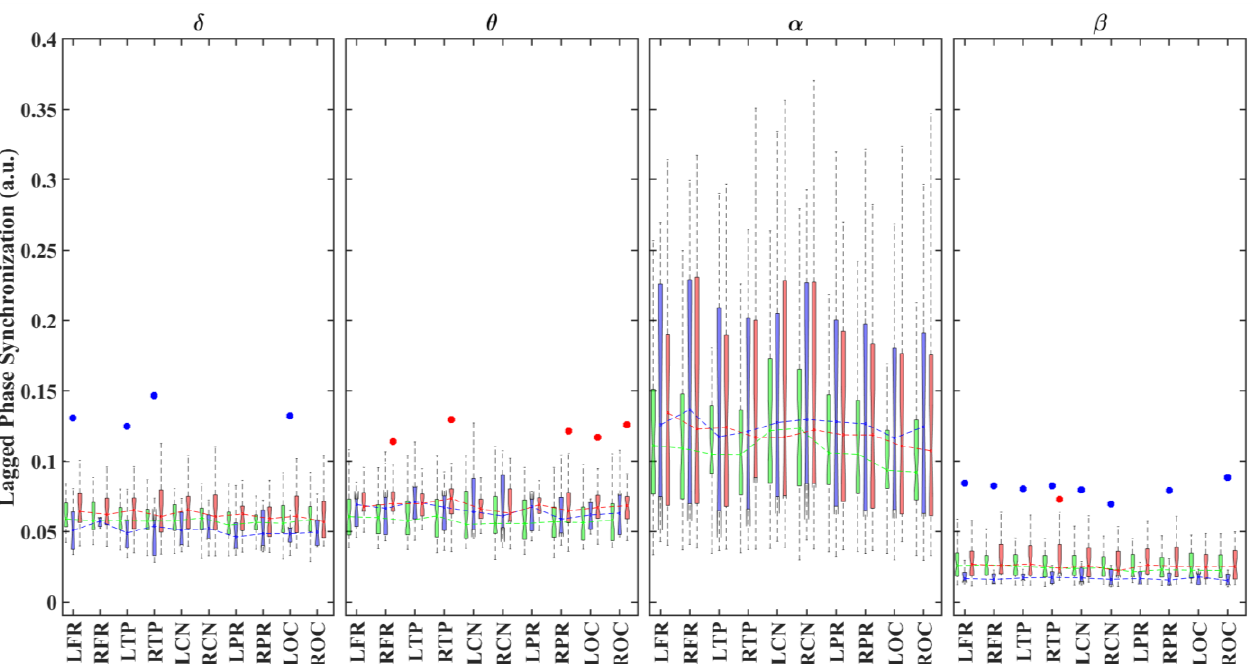
Figure 2. Boxplots displaying the median and interquartile ranges of the average (global) LPS values for each brain region and group (TD: green; ADHD I : blue; ADHD C : red) in different frequency bands. The points indicate statistically significant differences ( p < 0.05, 1000 permutations) between the ADHD C and TD (red) groups and between the ADHD I and TD (blue) groups. R/L: right/left; FR: frontal regions; TP: temporal regions; CN: central regions; PR: parietal regions; OC: occipital regions.